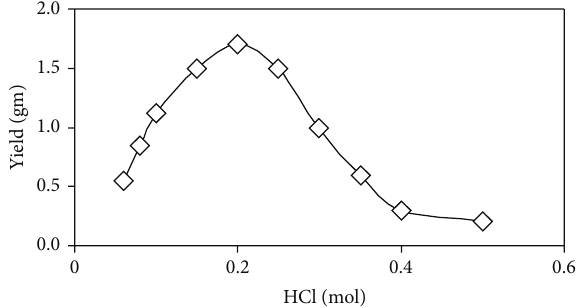
Figure 2: Yield-HCl concentration effect on the aqueous oxidative polymerization of poly-o-phenylenediamine (POPDA).